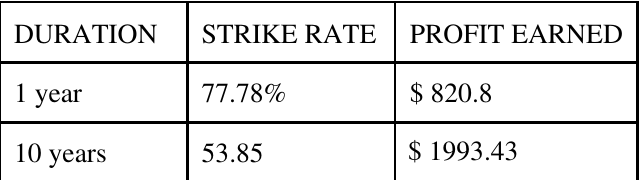
Table 4: Donchian Evaluation